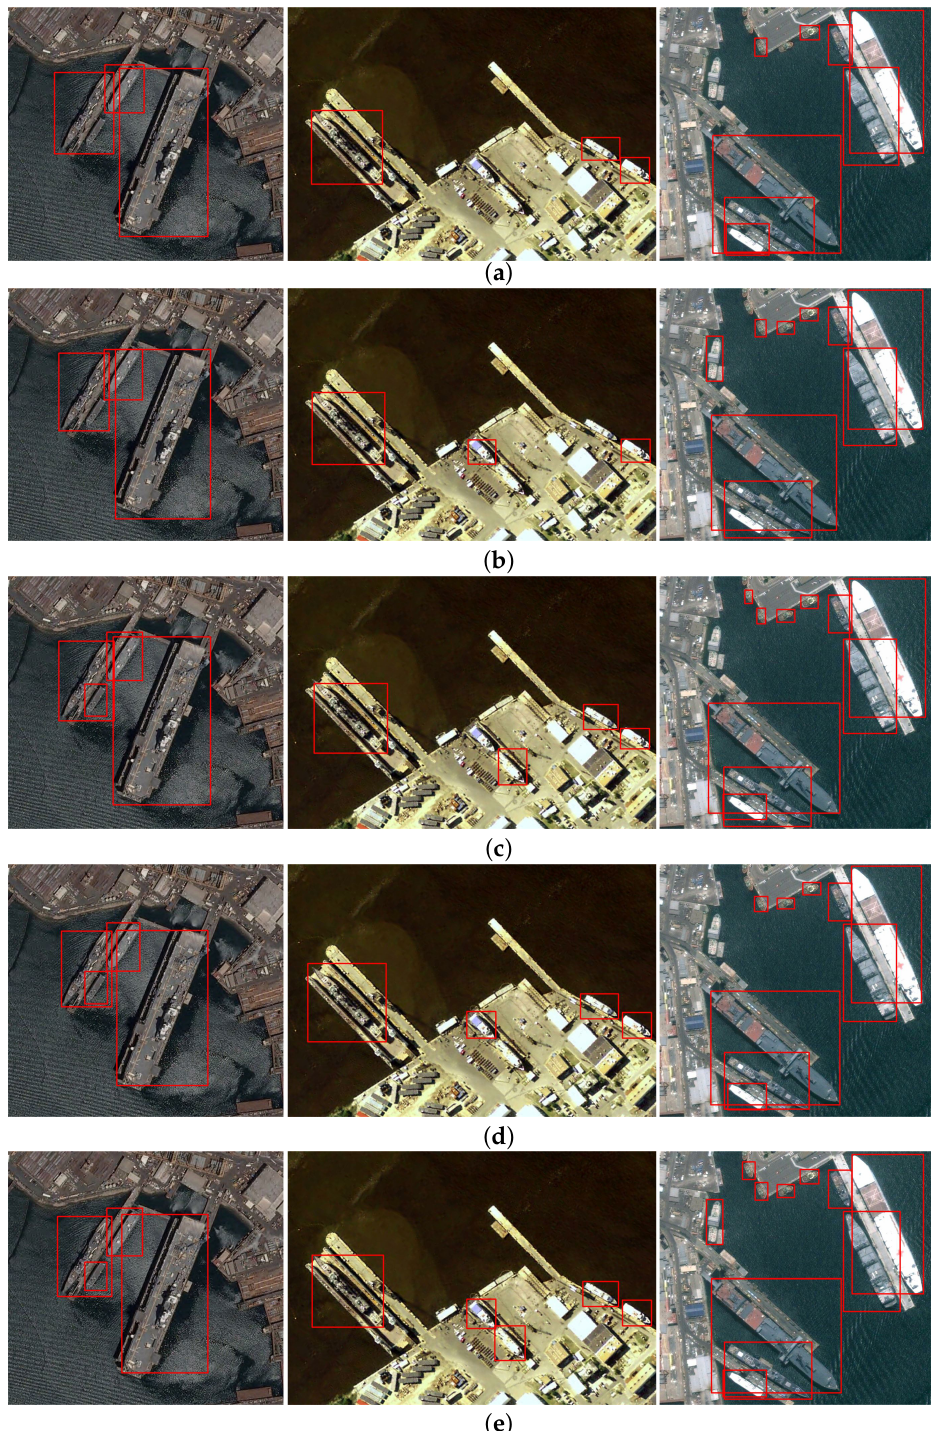
Figure 11. Comparison of the ship-detection results by different methods on the HRSC2016